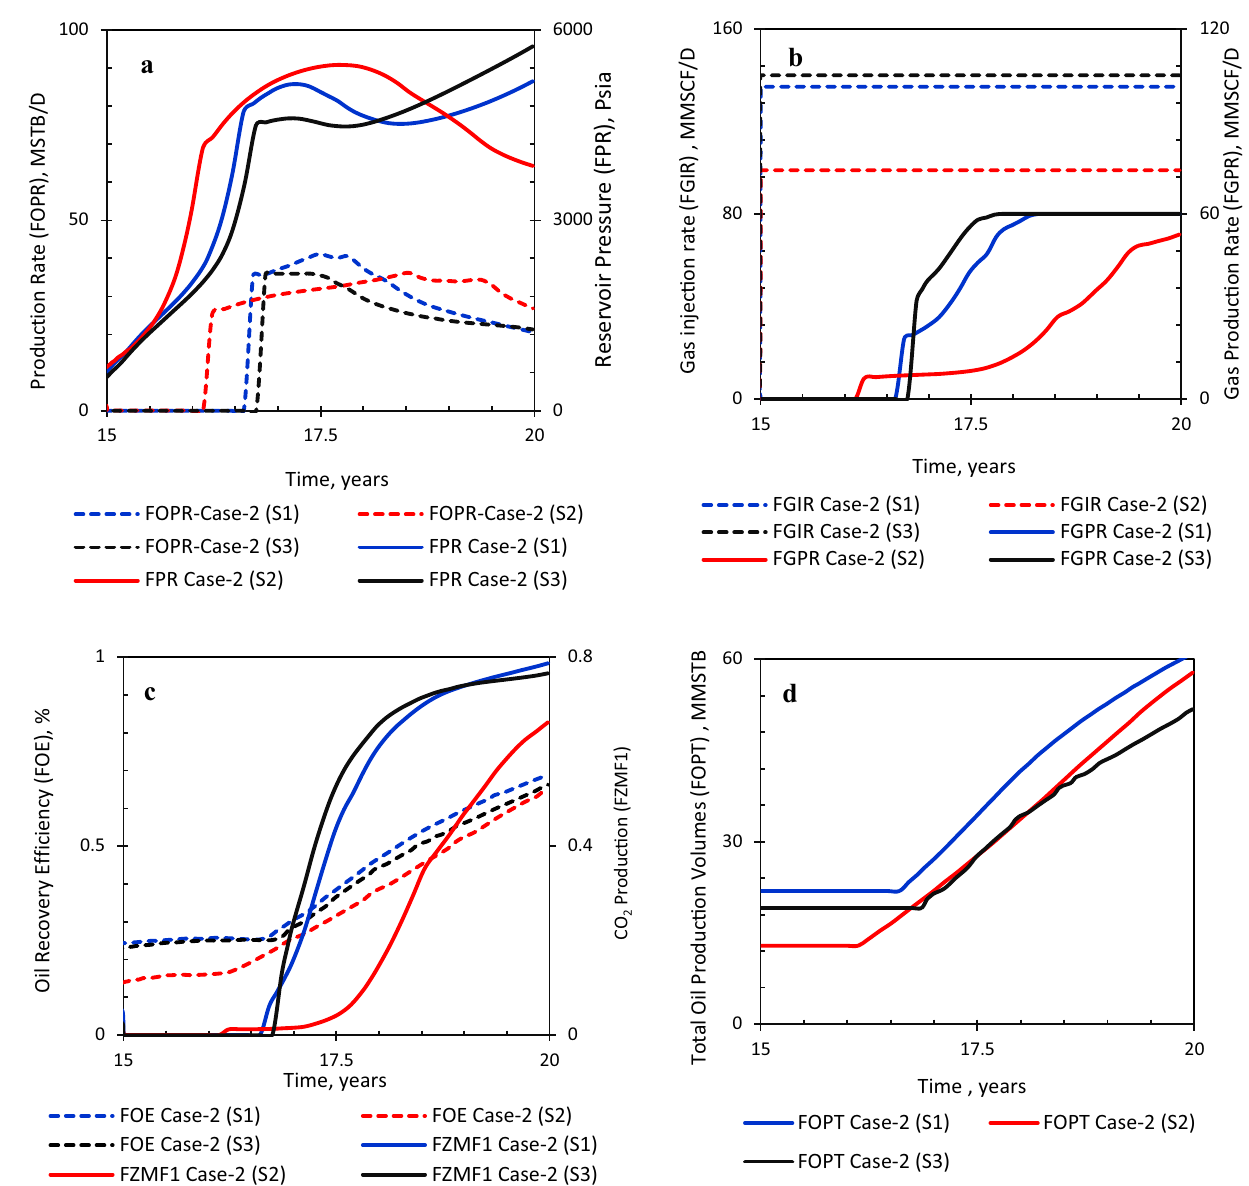
Fig. 11 Comparison between a FOPR & FPR, b FGIR & FGPR, c FOE & FZMP, and d FOPT of S1, S2 and S3